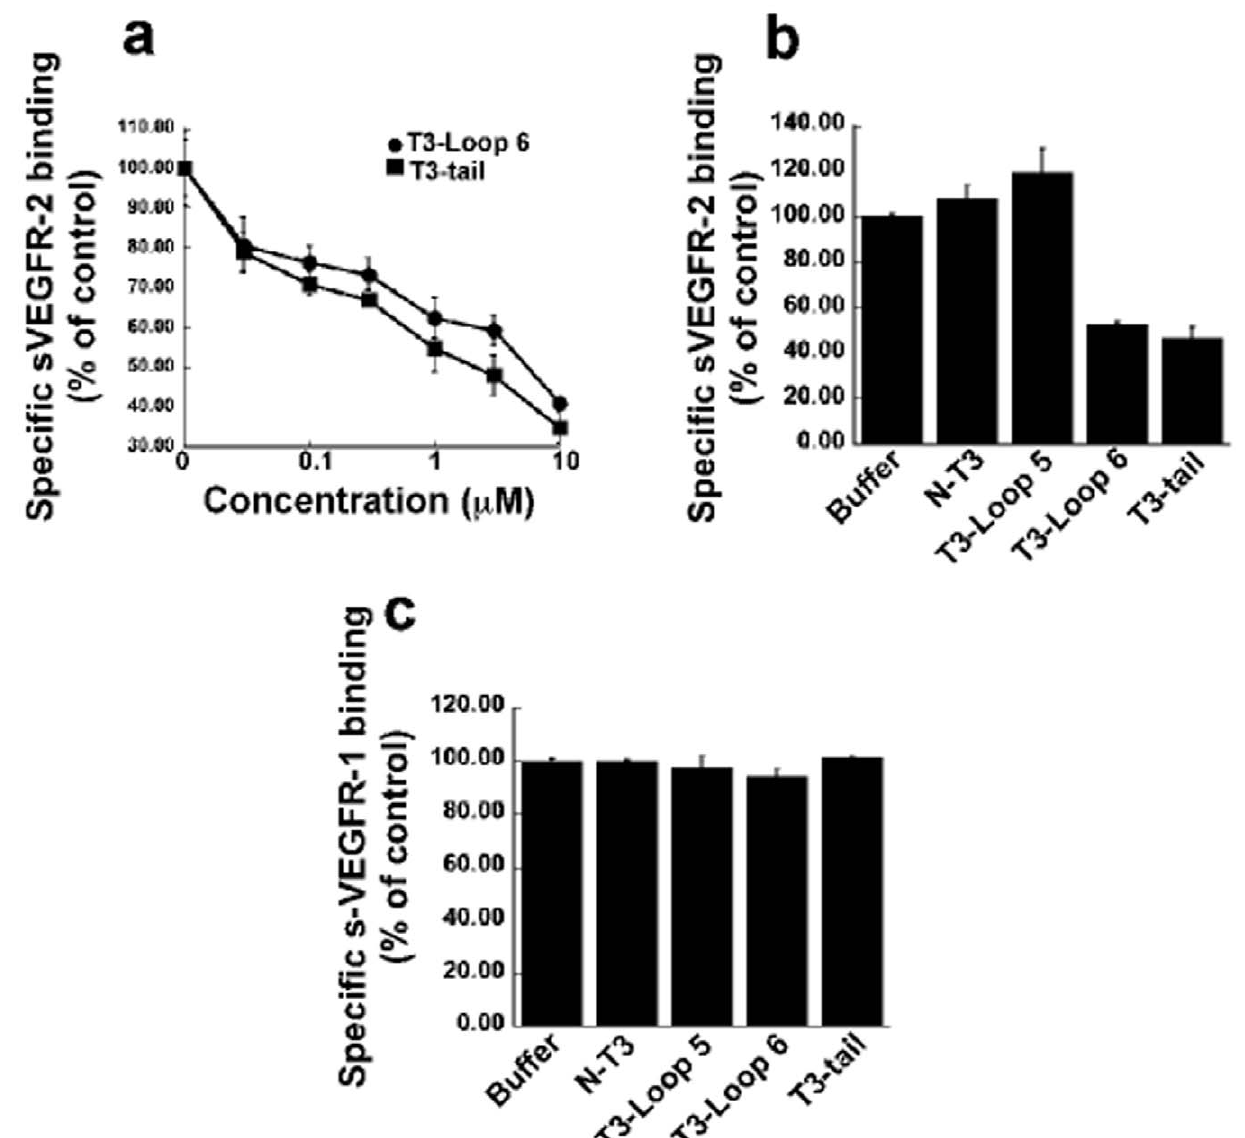
Figure 2. The effect of synthetic TIMP-3 peptides on binding of 50 ng/ml soluble (s) VEGFR-1 or –2 to immobilized VEGF. A competitive ELISA assay was used as described under ‘‘Materials and Methods’’ (a). Loop 6 and tail peptides inhibit sVEGFR-2-VEGF complexes in a concentration-dependent manner. (b) Loop5 and N-peptide have no effect on sVEGFR-2-VEGF complexes. (c) Loop 5, loop 6, tail and N-peptide are unable to inhibit sVEGFR-1-VEGF